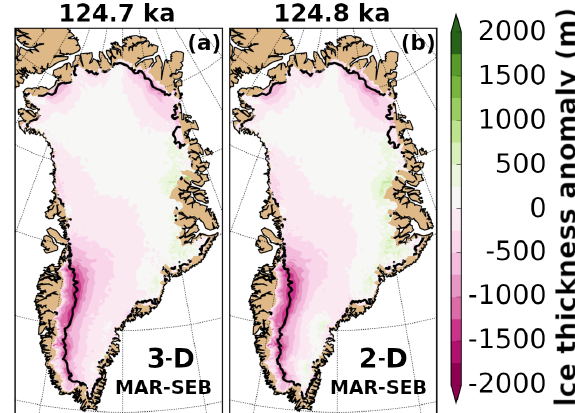
Figure 7. Ice thickness anomalies simulated with the control ( a ; 3-D higher-order) and the ice flow ( b ; 2-D SSA) experiments at the respective ice minimum. Anomalies are relative to the initial mod- ern ice sheet. The respective minimum time is indicated at the top of each panel. The ice margin is indicated with a solid black line (10m ice thickness remaining). A nonvisible ice margin is identical to the domain